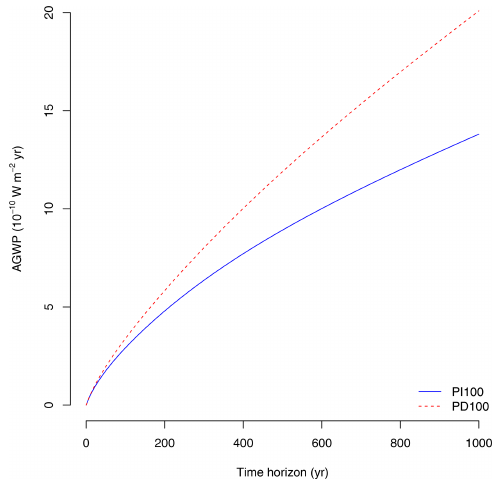
Figure 5. Absolute global warming potential (AGWP) due to the emission of 1Mg of CO 2 –C to the atmosphere for the two different IRFs (pre-industrial atmosphere with a pulse of 100Gt of carbon: PI100, and present-day atmosphere with a pulse of 100Gt of car- bon: PD100) reported by Joos et al.